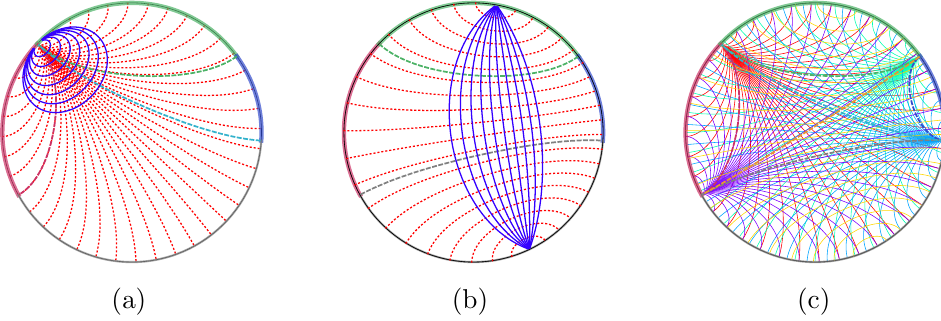
Figure 5 . Speci(cid:12)c foliations which generate the smooth (cid:13)ow con(cid:12)guration indicated in (cid:12)gure 4a, in particular generating (a) the (cid:13)ow v indicated by the solid blue curves) these give the thread bundles a and b , respectively. (c) All 5 foliations (color-coded as in (cid:12)gure 2) superposed on each other.